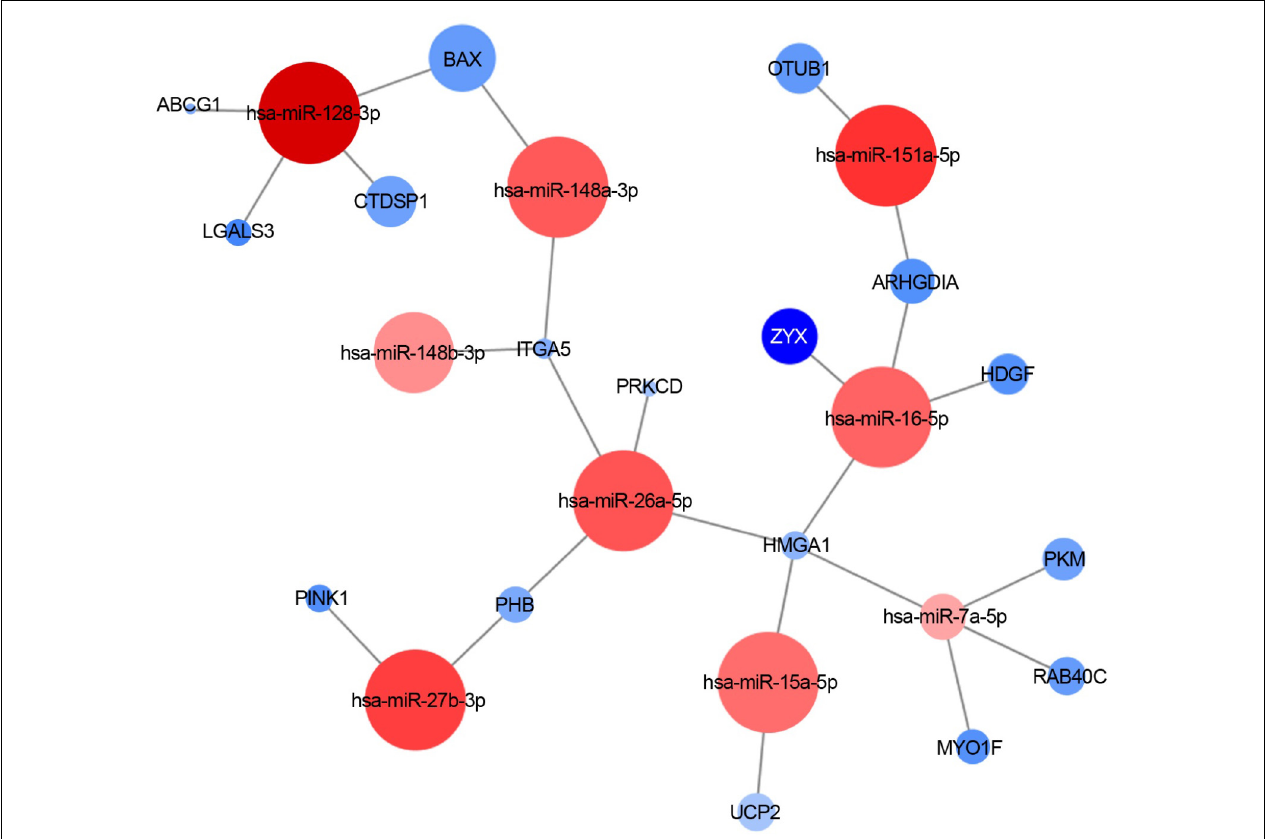
FIGURE 4 | miRNA-target interaction network. An example of experimentally validated miRNA-target gene interactions is visualized as a network (by Cytoscape 3.6.0). Nodes are colored according to the log2 fold change between sALS and HC ( red: downregulated; blue: upregulated), and the node size is proportional to the p -value in the DE